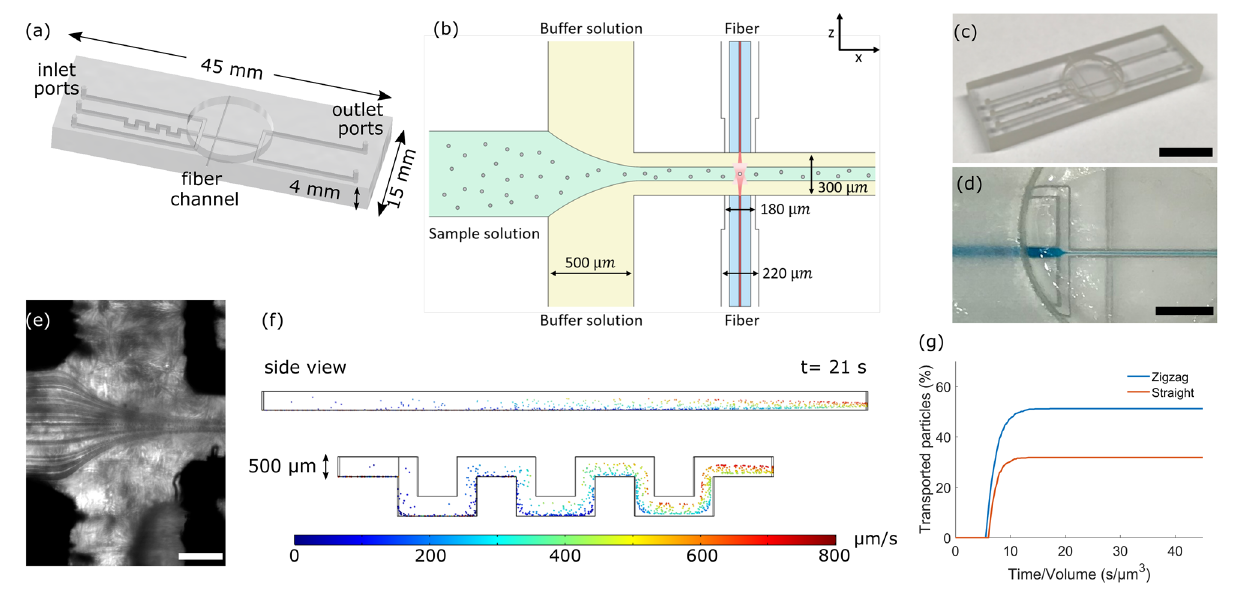
Figure 2. Design and proof-of-concept of the 3D printed microfluidic chip. ( a ) The 3D design of the microfluidic chip with the corresponding dimensions. ( b ) A schematic illustration of the principle of the dual beam optical trap system in the designed 3D printed microfluidic chip is shown. The sample solution is hydrodynamically focused and sheathed by the buffer solution. ( c ) An exemplar photo of the 3D printed microfluidic chip. Scale bar is 10 mm. ( d ) Water containing color additive is flown through the chip to simulate the sample solution. Scale bar is 4 mm. ( e ) Trajectory of 10 µ m polystyrene particles flowed through the sample channel. Scale bar is 200 µm. COMSOL simulations are presented in ( f ) showing the speed of the transported particles for a straight (top) and square zig–zag mixer (bottom) structure. The percent transported particles at the end of zig–zag and straight channels with the same total path length is shown in ( g ) as a function of time/